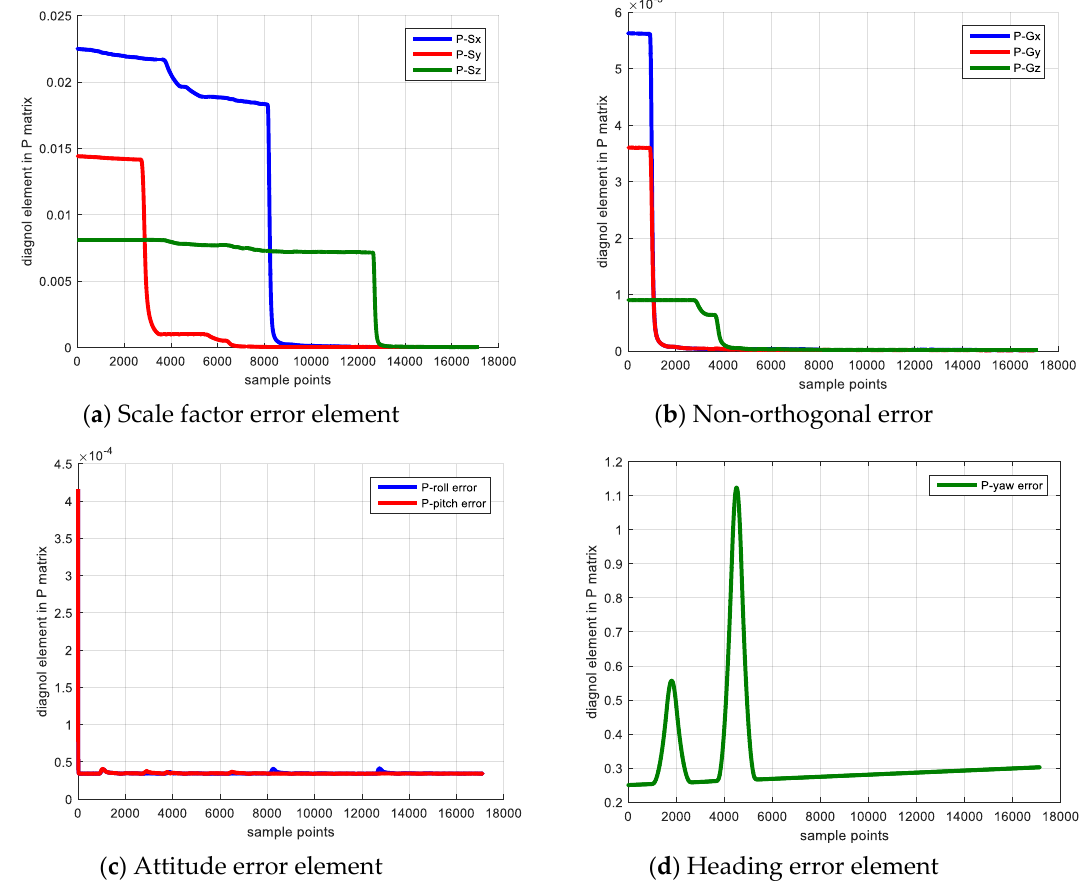
Figure 3. Elements of P matrix.